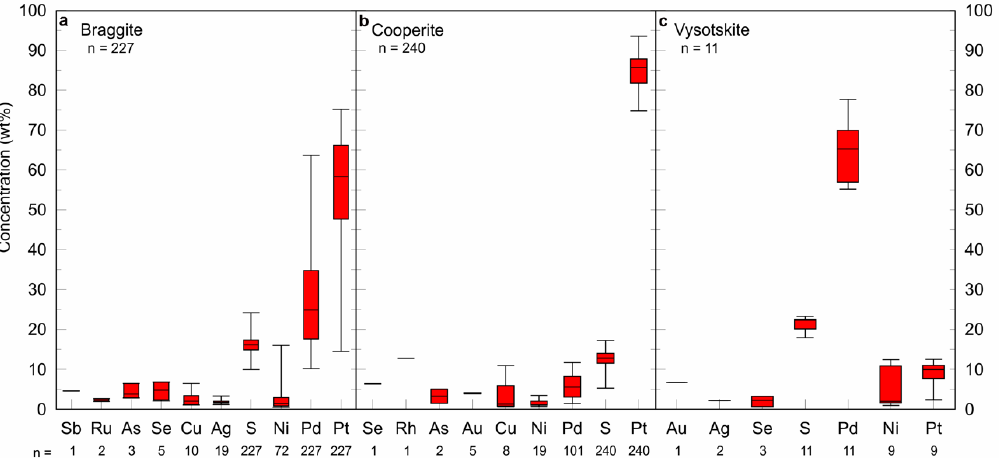
Figure 9. Multi-element box and whisker plots of elemental variation (in wt%) in ( a ) braggite, ( b ) cooperite, and ( c ) vysotskite grains. Whiskers represent the range of minimum and maximum values. The short line within each box represents the median value, which separates the box into two parts (i.e., lower 25th–50th percentile group and upper 50th–75th percentile). The n below the axis: number of grains containing the element of interest.